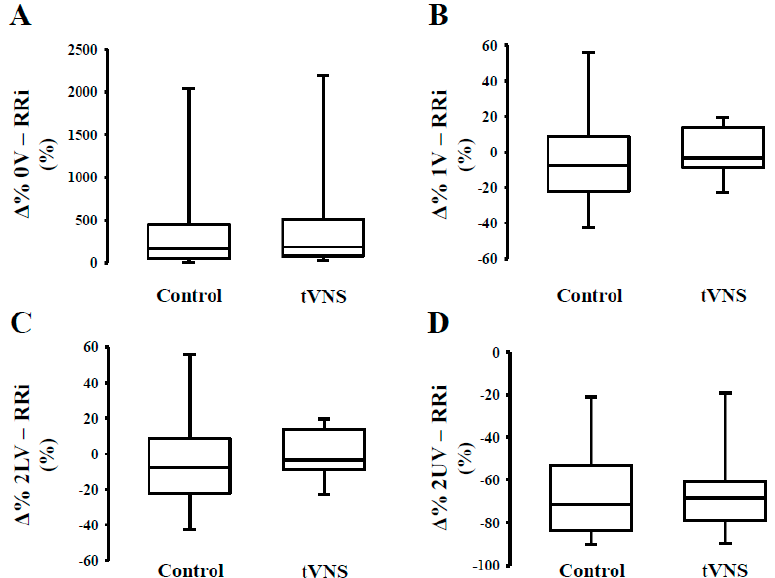
Figure 1. Response ( ∆ %) of cardiac autonomic control to orthostatic stress during transcutaneous vagus nerve stimulation in healthy subjects. Note that the orthostatic challenge promoted similar responses on cardiac sympathetic modulation (Panel A ) and cardiac parasympathetic modulation (Panel C and D ) independent of the stimulus (control or tVNS). Similar results are observed for 1V% (Panel B ).